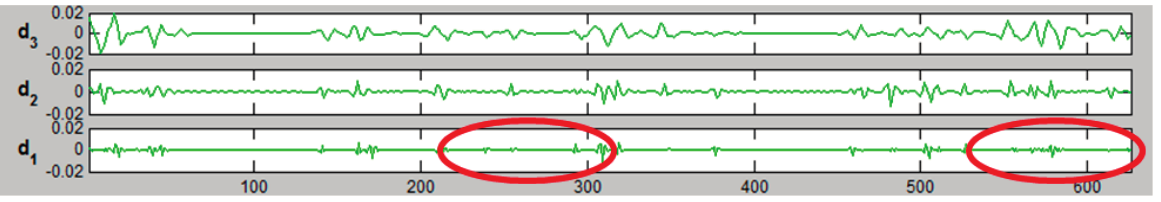
Figure 14. Details of d1, d2 and d3 of TLS signal decomposition, wavelet “sym3”, eight levels.